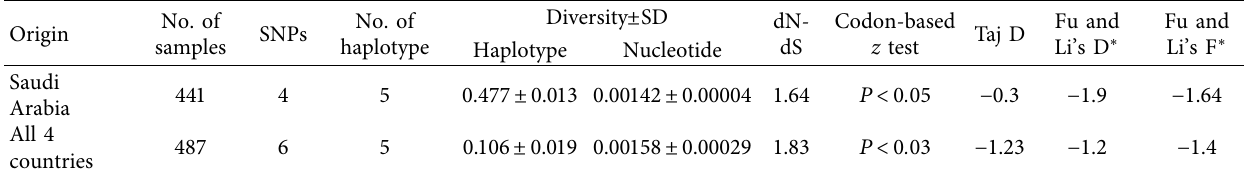
Table 2: Estimates of nucleotide diversity, natural selection, haplotype diversity, and neutrality indices of C-terminal PfKAHRP . Origin